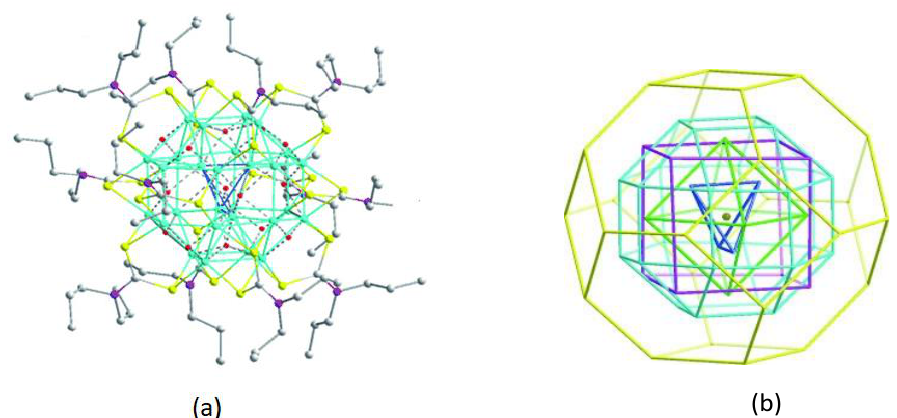
Figure 13. ( a ) Molecular structure of the cation in [Cu 28 (H) 15 ( µ 4 -S 2 CNR 2 ) 12 ][PF 6 ] and ( b ) a representation of the cluster core framework in which a Cu 4 tetrahedron is encapsulated by a rhombicuboctahedral C 18 moiety. Reproduced with permission from [106]. Copyright 2014 John Wiley and Sons.